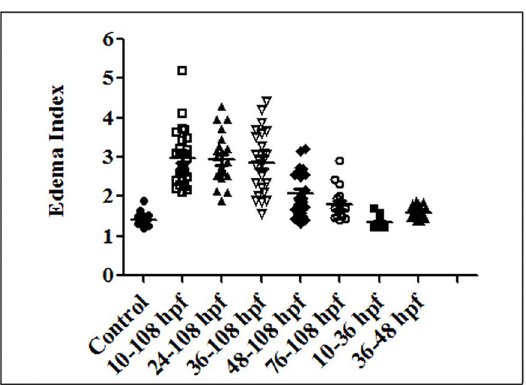
Figure 2. A scatter plot showing that sodium nitrite affected zebrafish heart development starting from 36 hpf. Nitrite- exposed embryos were treated with 100 mg/l sodium nitrite for different time window shown in X-axis. EI (shown in Y-axis) of each embryos was measured and shown in the plot. Average 6 standard errors of EIs were shown in lines.